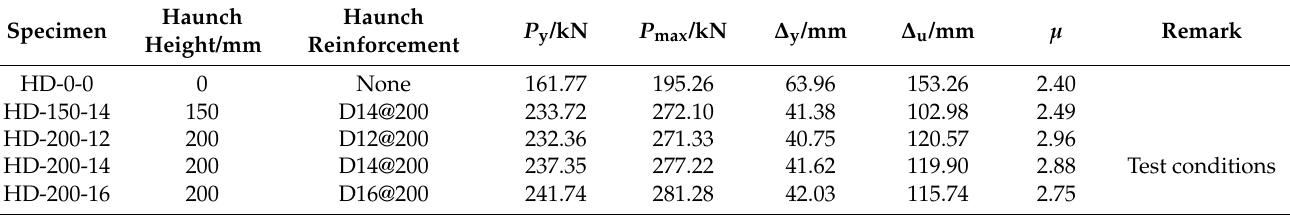
Figure 12. Load – displacement curve (effect of haunch size and reinforcement). Figure 12. Load–displacement curve (effect of haunch size and reinforcement). Table 4. Analysis parameters and calculation results of haunch height and